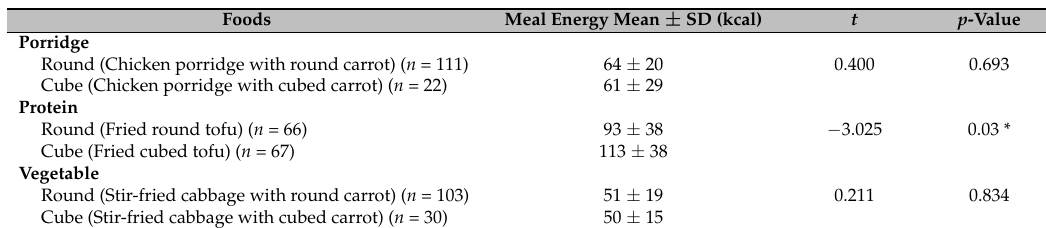
Table 13. Comparison of meal energy of food selection by subjects between round- and cube- shaped food ( n = 133)